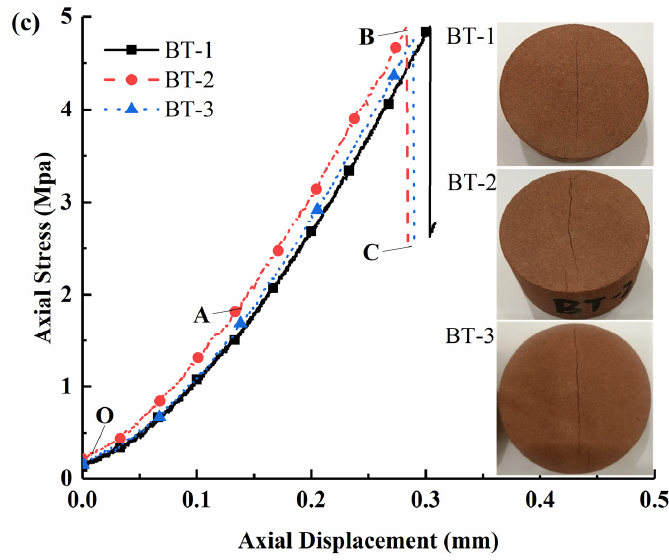
Figure 5. Stress–strain curves and failure modes of specimens in uniaxial tensile test, ( a ) DTT of flattened cylinder specimen, ( b ) DTT of intact cylinder specimens, ( c ) BT of Brazilian disc. Table 1. Test results of sandstone specimens in DTT and BT.